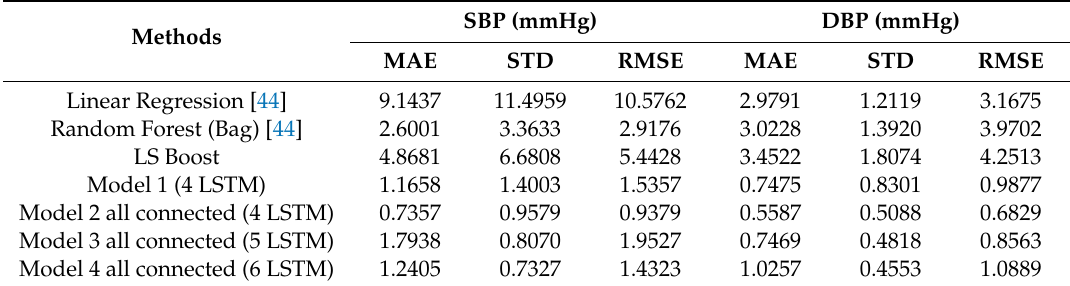
Table 3. The proposed models compared with traditional machine learning methods on 1370 records. SBP Methods